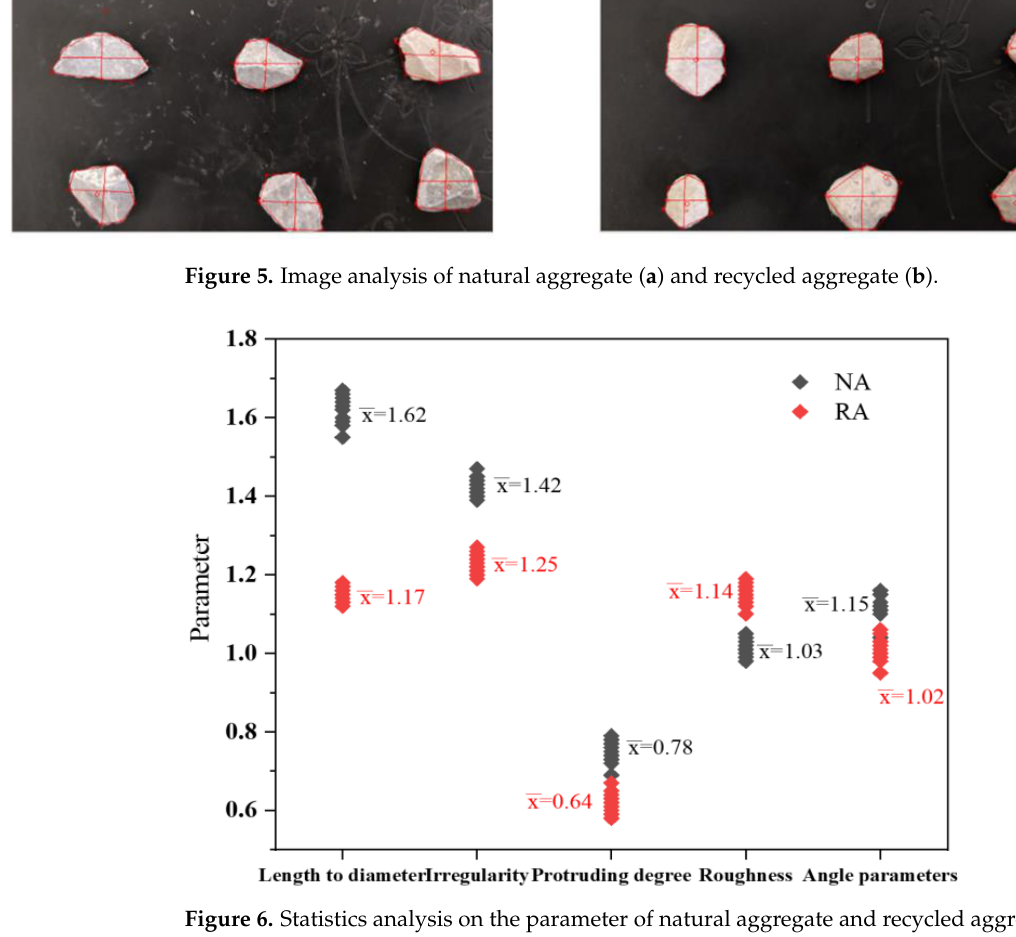
Figure 6. Statistics analysis on the parameter of natural aggregate and recycled aggregate.